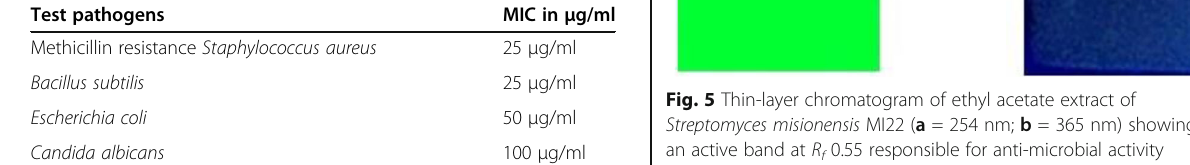
Table 3 Minimum inhibitory concentration of ethyl acetate Streptomyces misionensis MI22 against test human pathogens Test pathogens